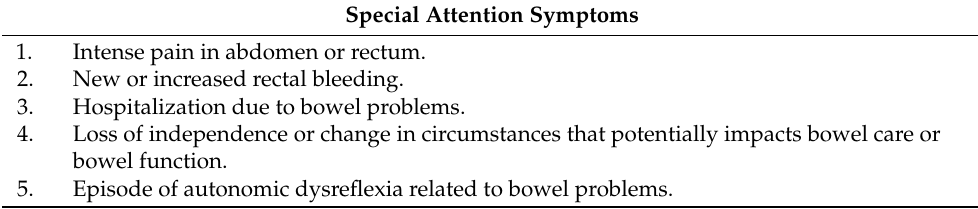
Table 1. Special attention symptoms of neurogenic bowel